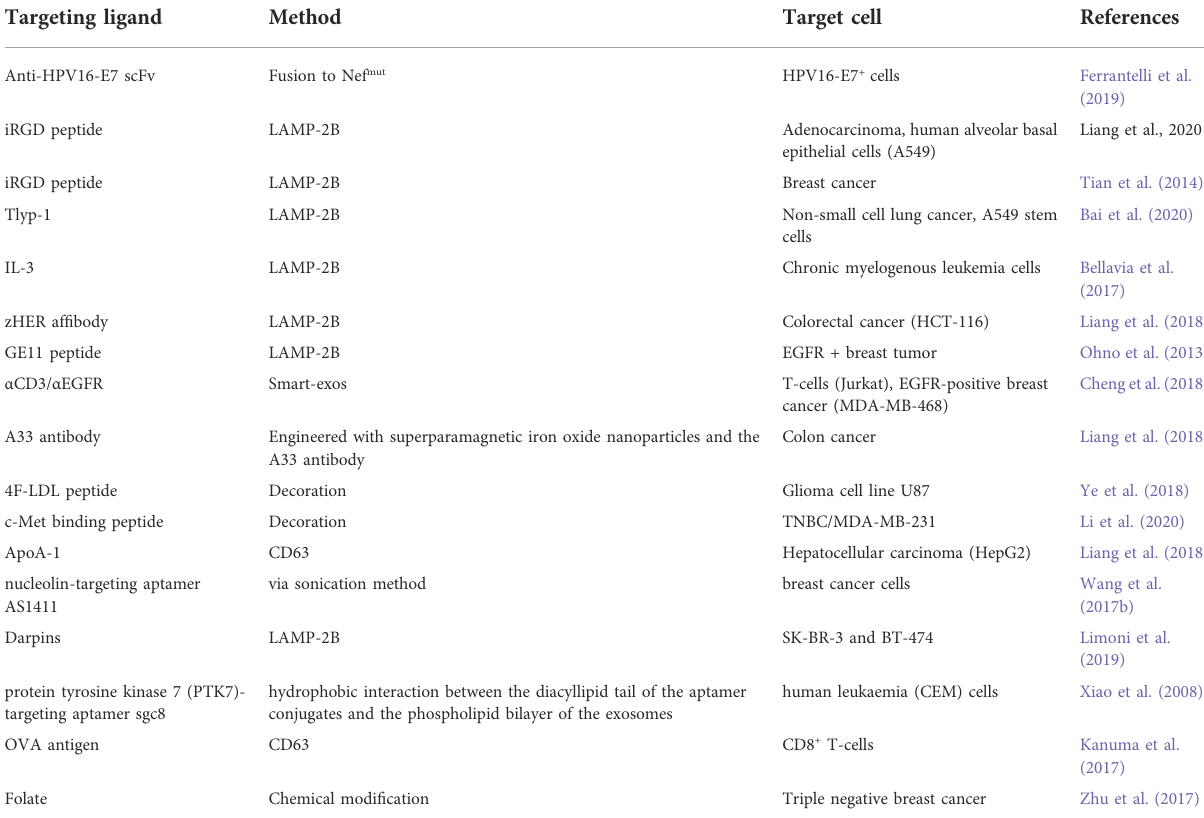
TABLE 1 Methods to target exosomes to a particular cell type or